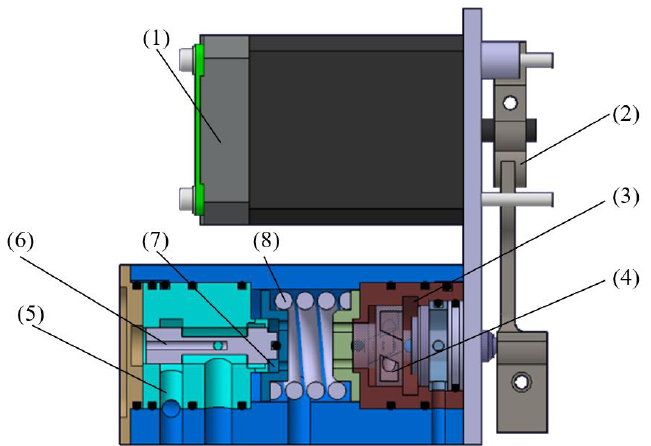
Figure 1. Diagram of 2D digital buffer valve structure. (1) Electromechanical converter; (2) transmis- sion mechanism; (3) pilot valve sleeve; (4) pilot main spool; (5) main valve sleeve; (6) main spool; (7) spring seat; (8)